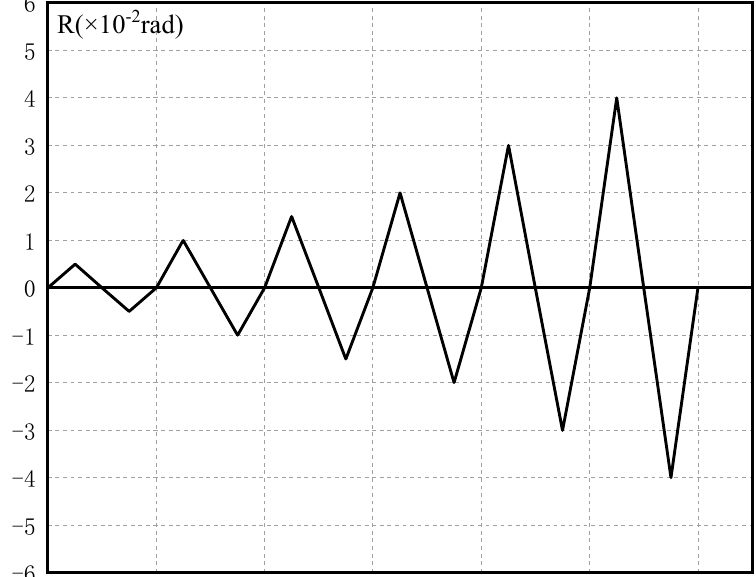
Figure 9. Loading protocol.